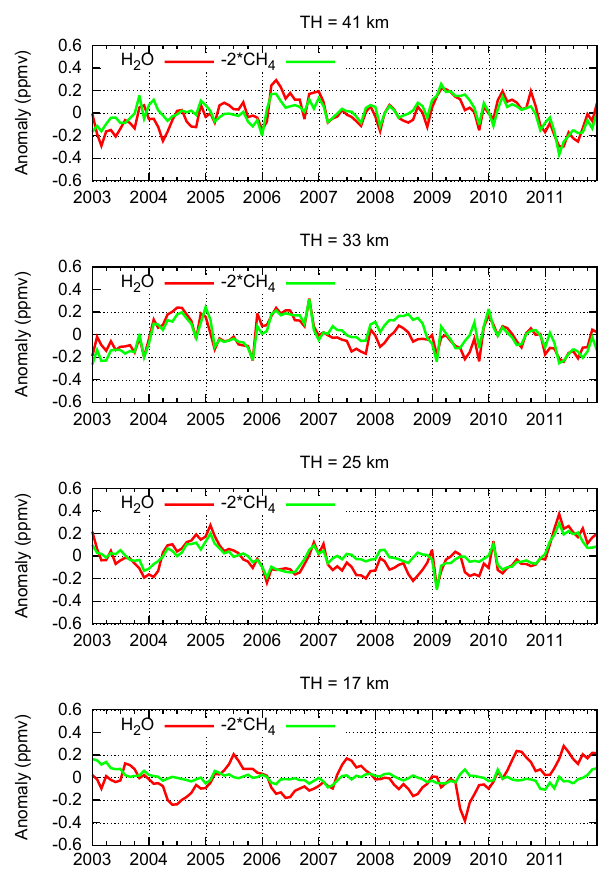
Figure 8. Time series of SCIAMACHY water vapour and methane anomalies at different altitudes. Methane data have been scaled by a factor of −